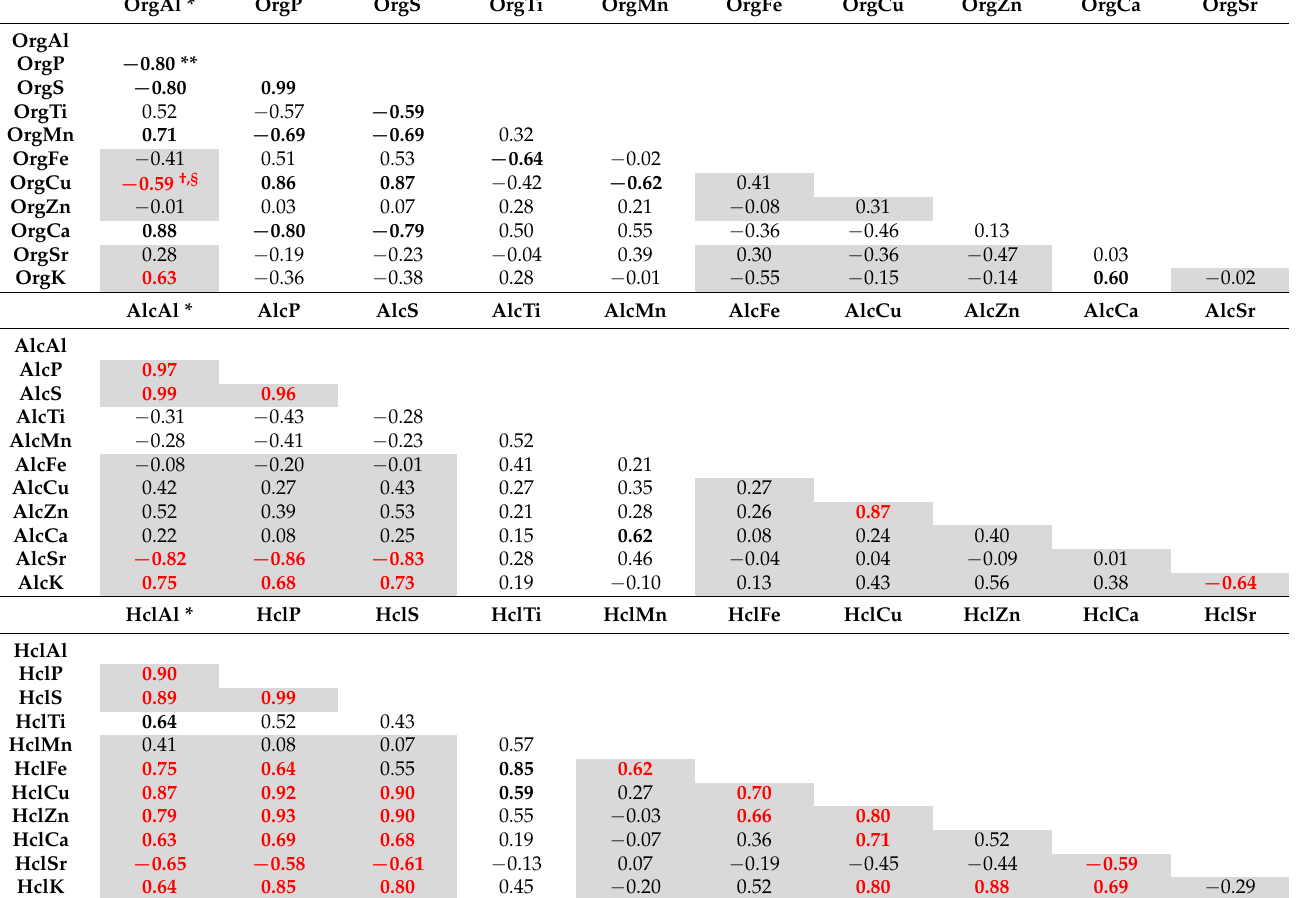
Table 2. Spearman rank correlation matrices for mean elemental contents in trunks of the four